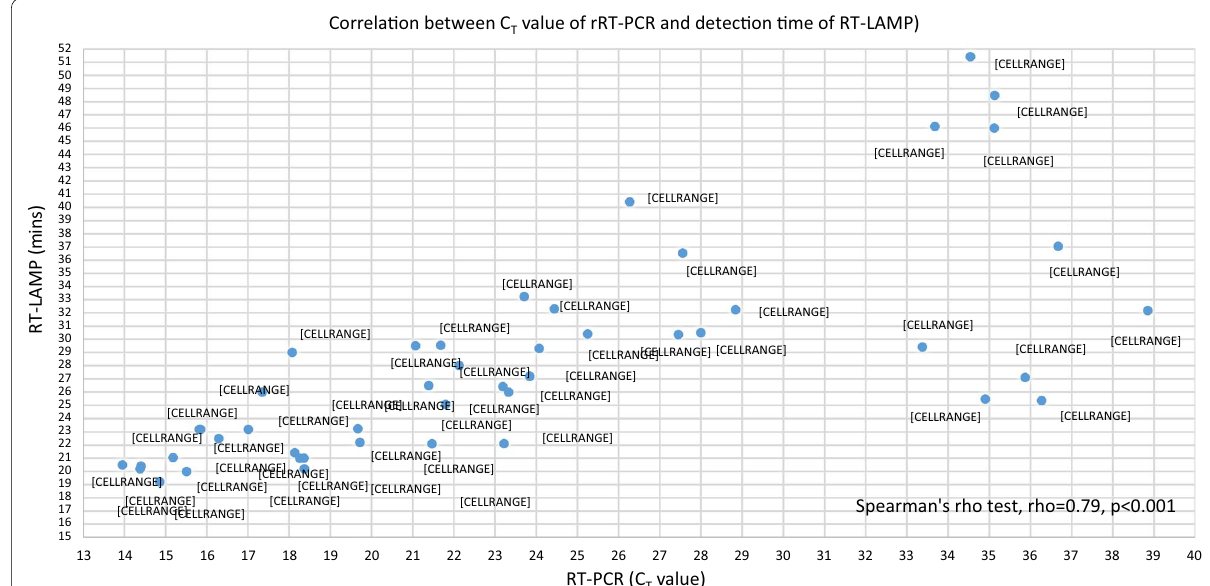
Fig. 1 Correlation between C T value of rRT-PCR and detection time of RT-LAMP. rRT-PCR, real time reverse transcription polymerase chain reaction; RT-LAMP, reverse transcriptase loop-mediated isothermal amplification; min, minutes; C T , cycle